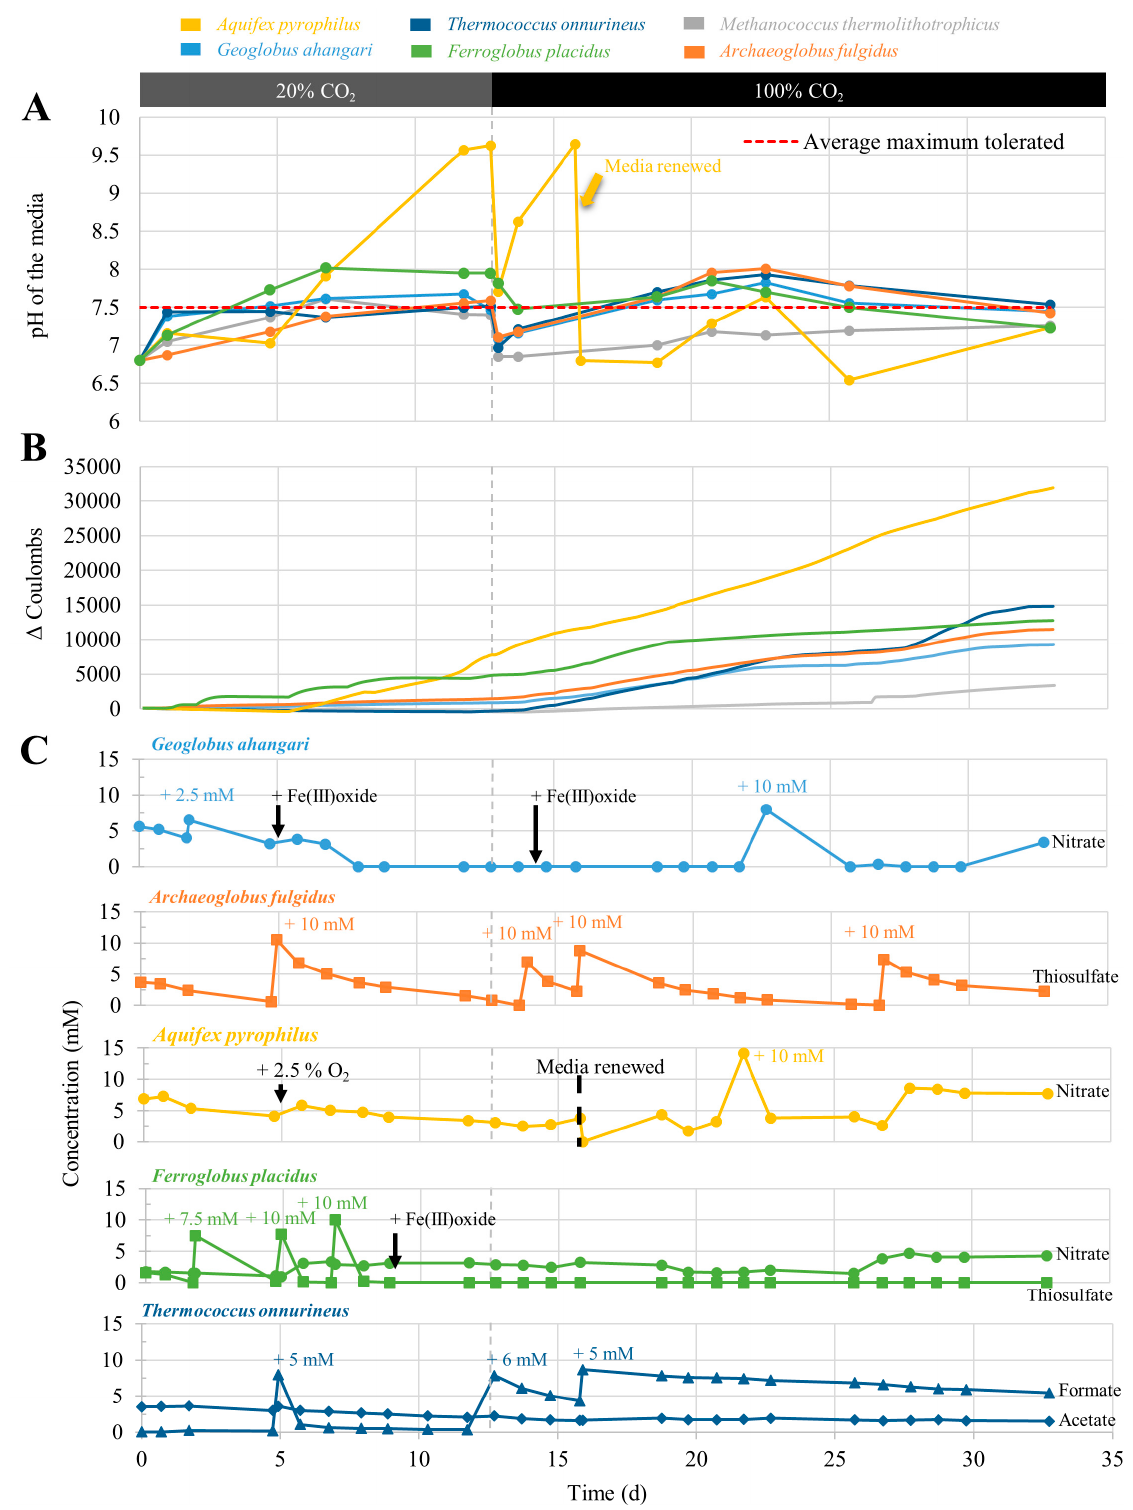
Figure 2. ( A ) The pH evolution; ( B ) current consumption between consecutive timepoints calculated by (I biotic − I abiotic ) ∗ (t n − t n − 1 ): for graphic depiction, Δ coulombs was subsequently averaged over 30 timepoints to normalize the curve; and ( C ) consumption of soluble electron acceptors in long ‐ term experiments over time. CO 2 was increased from 20% to 100% on day 13. In Aquifex pyrophilus , the media were renewed on day 16 due to high pH. Fe(III) reduction could not be quantified in this experiment due to partial sedimentation in the H ‐ cell and O 2 contamination of the samples.